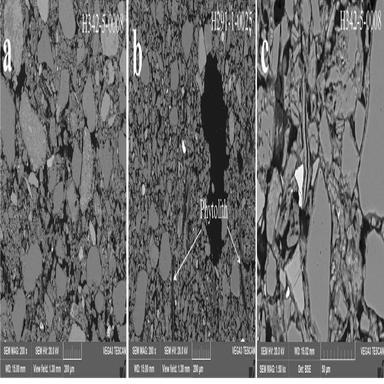
The BSE micrographs of the core samples with Texture B.